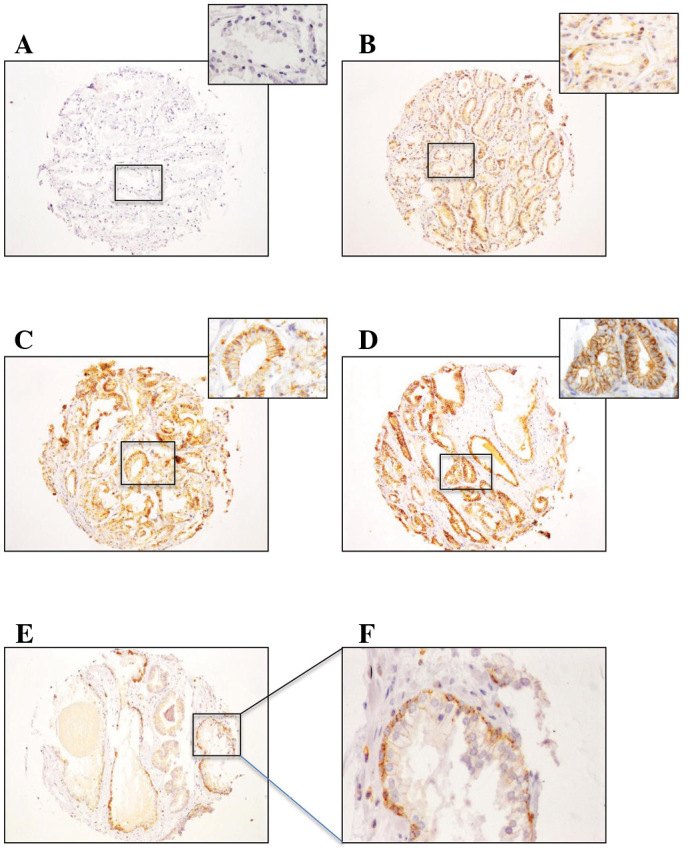
Examples of c-Met immunostaining in prostate cancer and normal tissues. (A) Lack of staining; (B) weak membranous staining; (C) moderate membranous staining; (D) strong membranous staining; (E) strong membranous staining in basal cells; (F) magnification of (E).